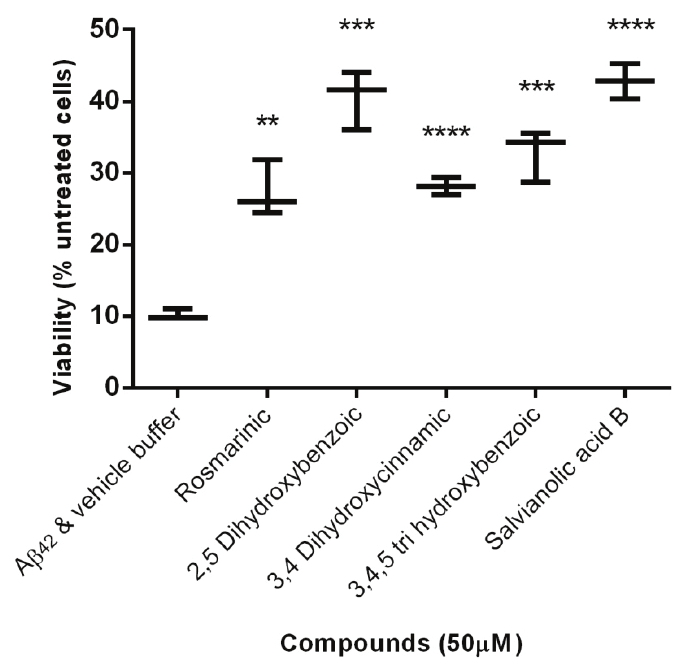
Figure 4. Cytotoxicity effect of freshly prepared HFIP pretreated A(cid:2) 42 peptide (5 (cid:7)M) on C. glabrata